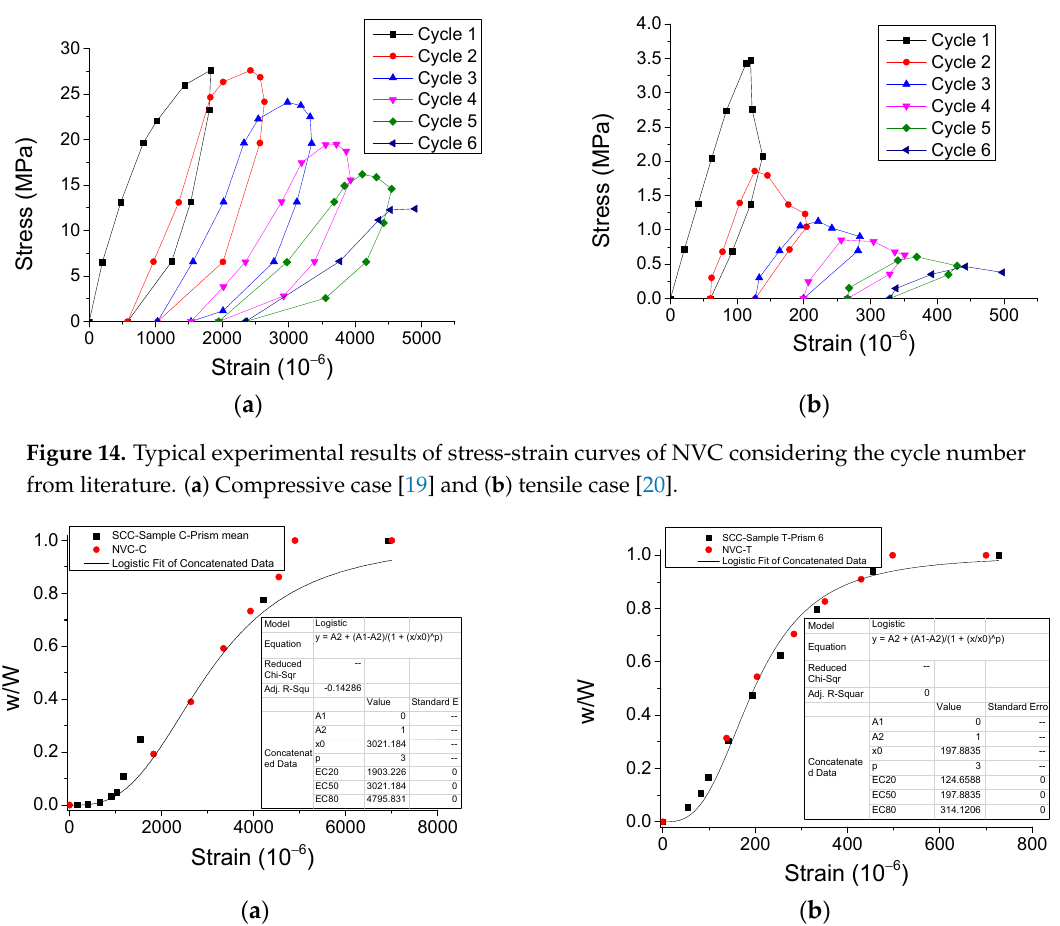
Figure 15. Evolution of normalized energy dissipation: w / W v.s. ε . ( a ) Compressive case and ( b ) tensile case.